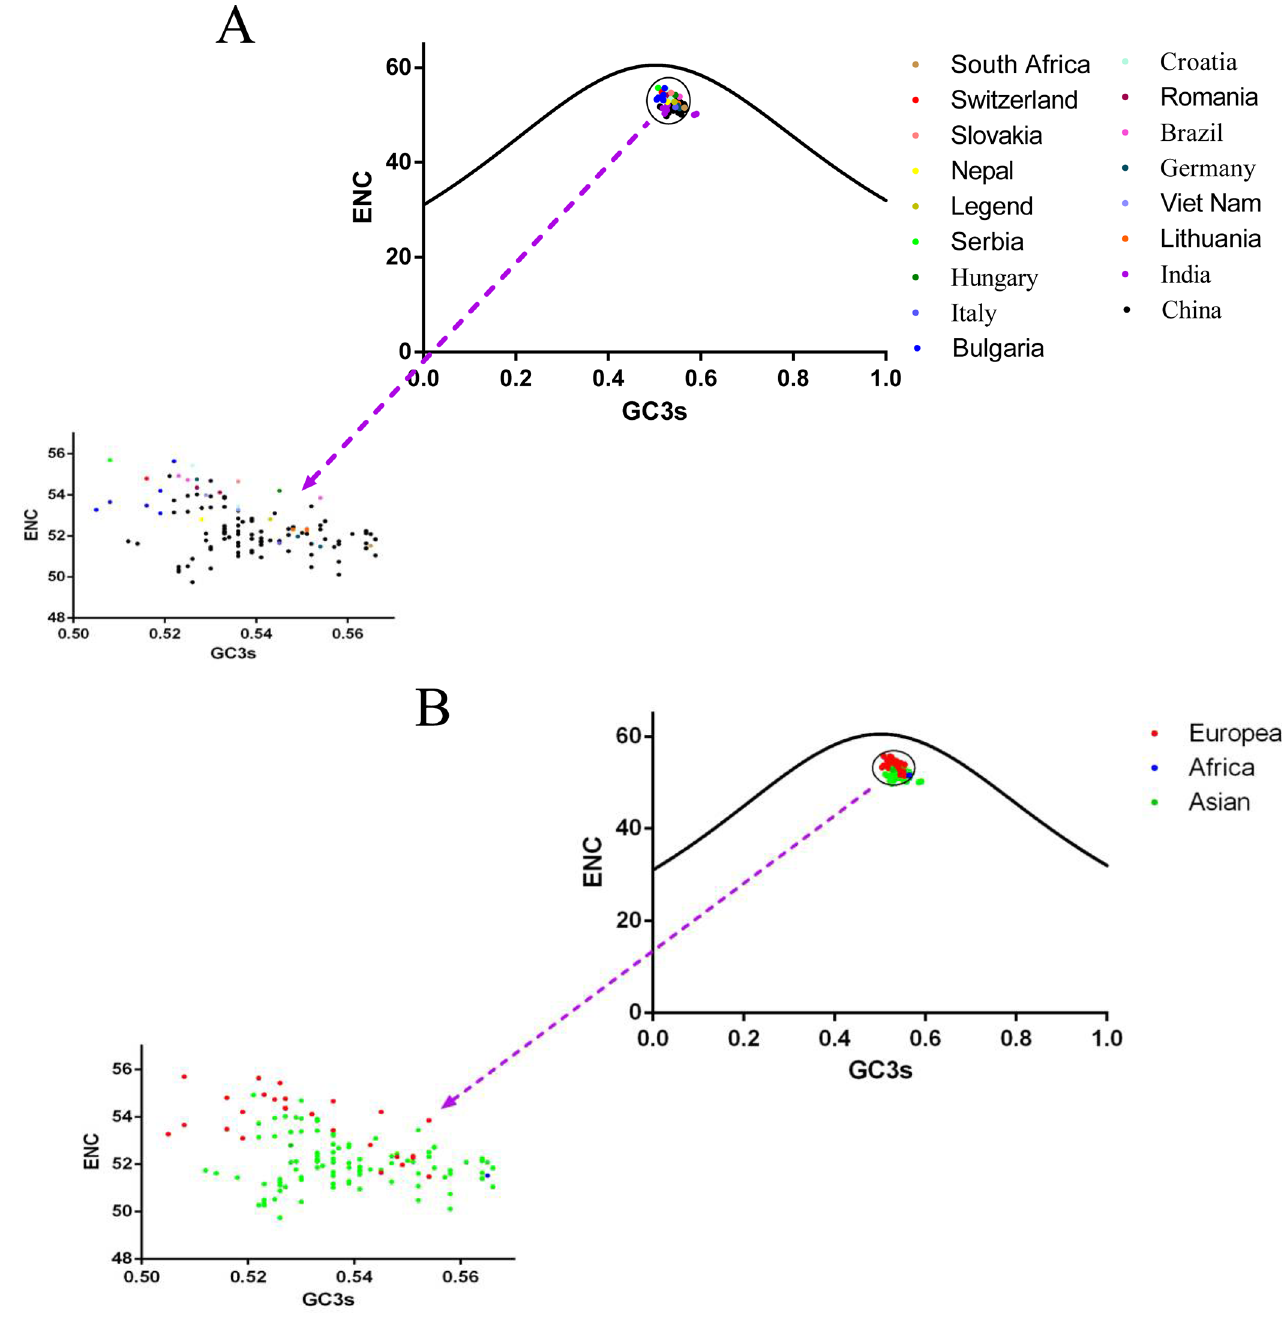
Fig 1. ENC plots displaying the relationships between ENC and the GC content at the third codon position (GC3s) in relation to geographical distribution. (A) isolated countries, (B) isolated continents, depictedin different colors. It’s essentialto note that the curve represent the expectedrelationship betweenENC and GC3s, thus, justly GC3s contributes to the codonusage bias. bias. Therefore, a plot of the 1st axis and the 2nd axis of the isolated strains according to the geographical distribution was drawn (Fig 3). This explained that the different isolated coun- tries with CSFV are dispersed, and far away from the origin, confirming mutation pressure.